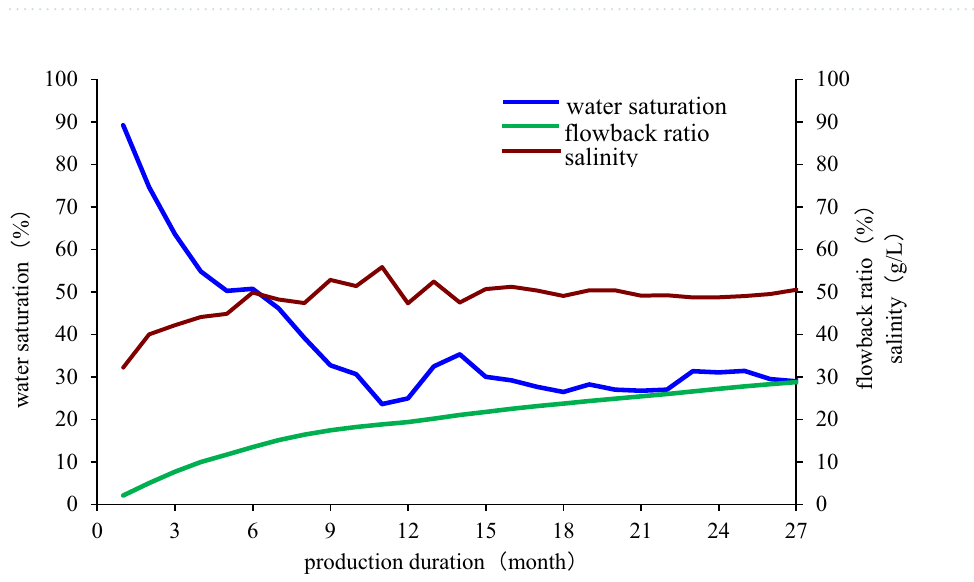
Figure 6. Curve of water saturation, salinity and flowback rate in Qingcheng